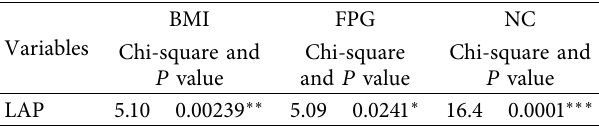
Table 7: Pairwise comparison of ROC of AUC with indexes di- agnostic